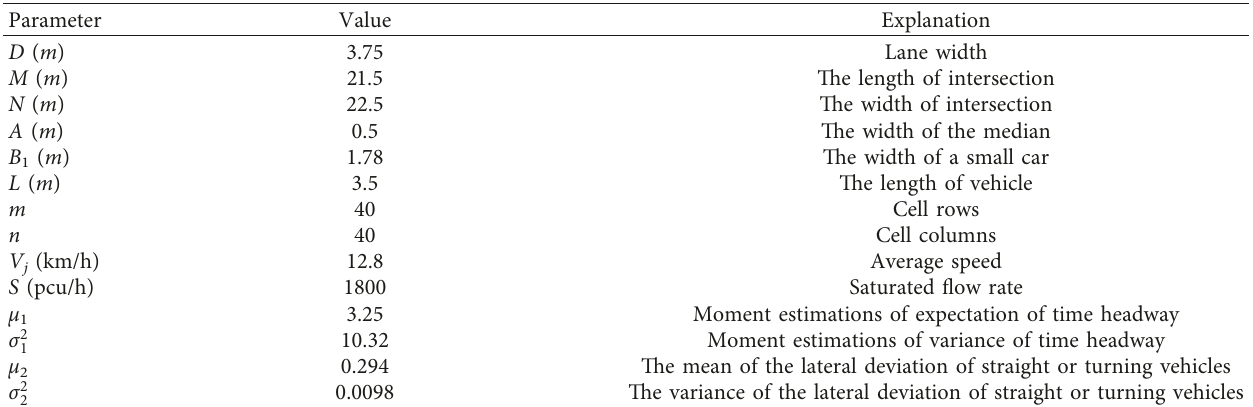
Table 2: Parameter